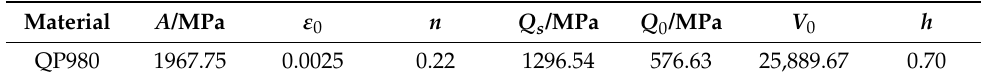
Table 2. Hardening parameters.